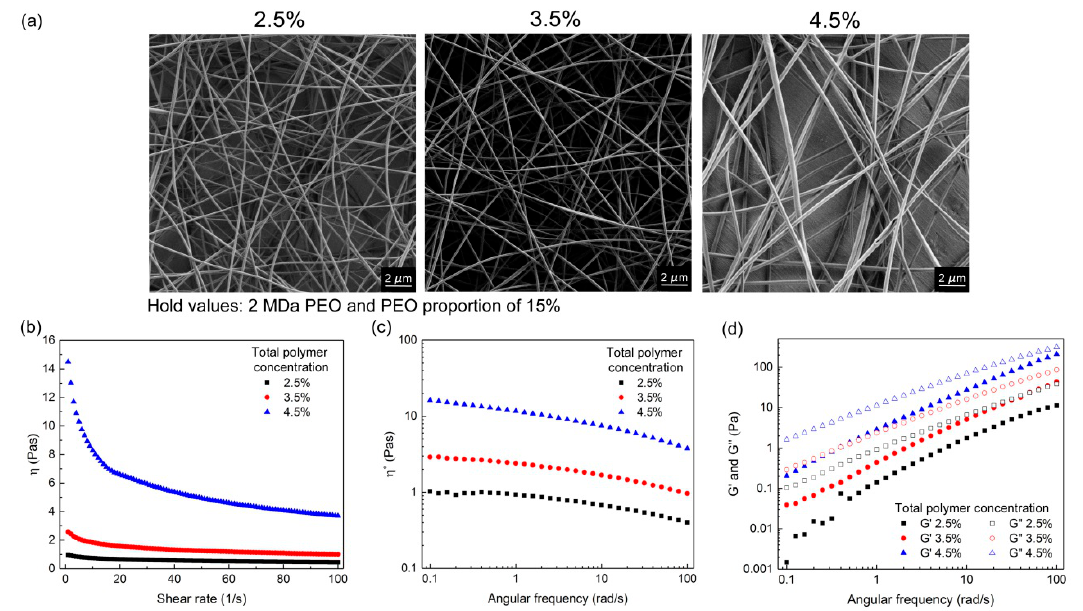
Figure 3. ( a ) scanning electron microscopy images of nanofibers obtained from polymer-blend solutions with increasing total polymer concentrations (as indicated), with 2 MDa PEO and PEO proportion of 15%; ( b – d ) corresponding viscosities ( η ) ( b ); complex viscosities ( η * ) ( c ); and storage ( G’ ) and loss ( G” ) moduli ( d ).